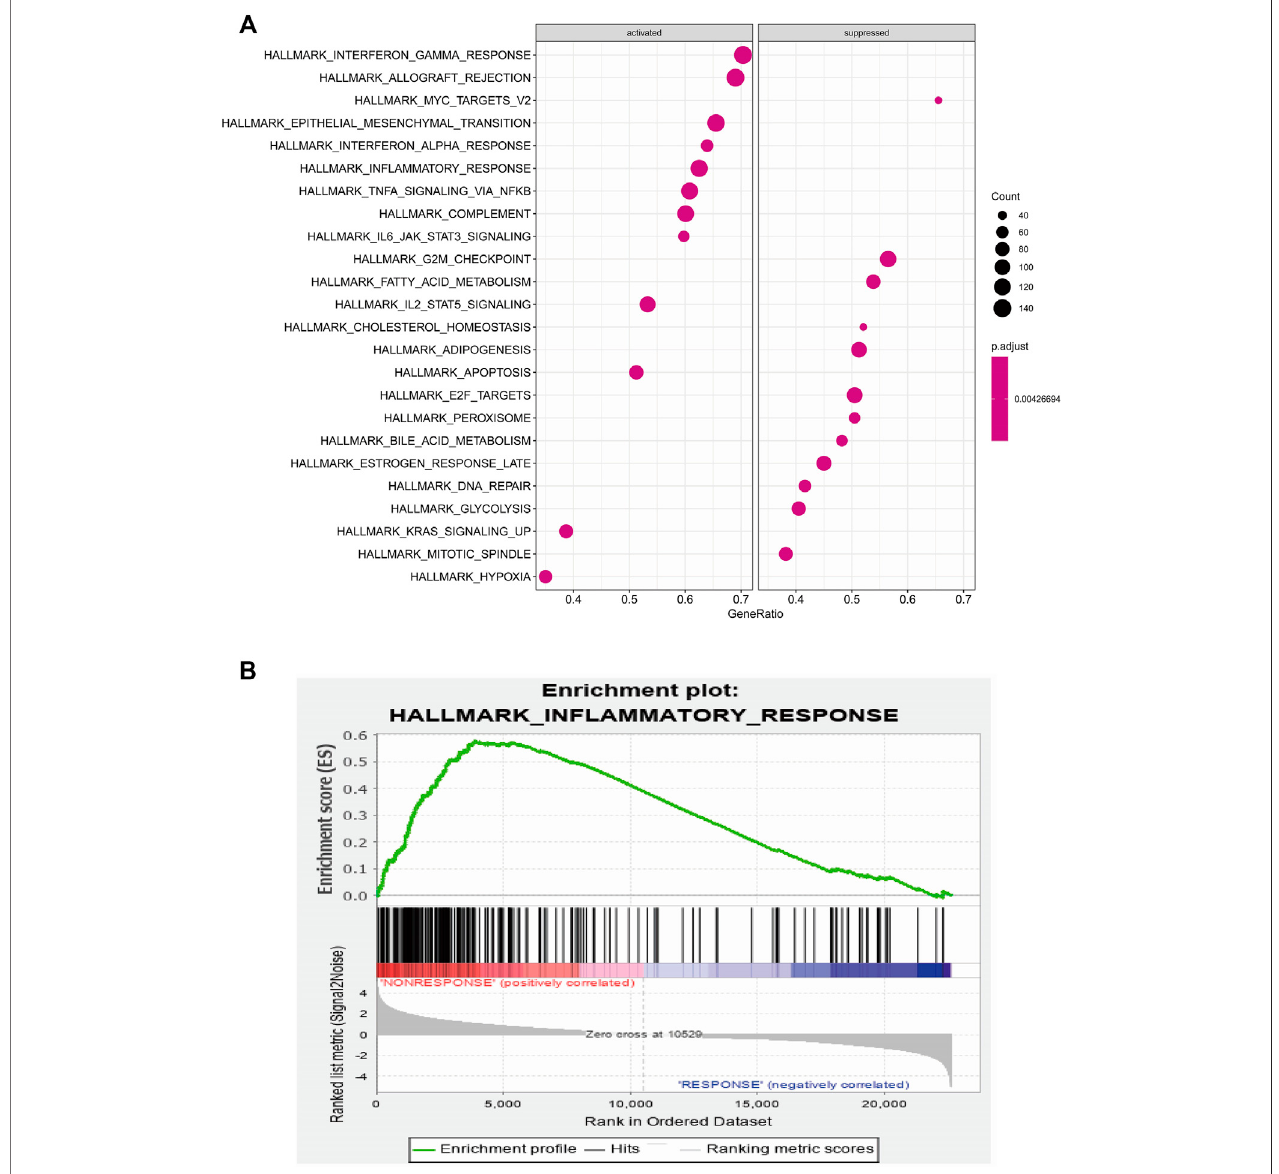
FIGURE 4 | (A) GSEA analysis of IL-6 and IL-6 related genes (B) In fl ammatory response of GSEA analysis.